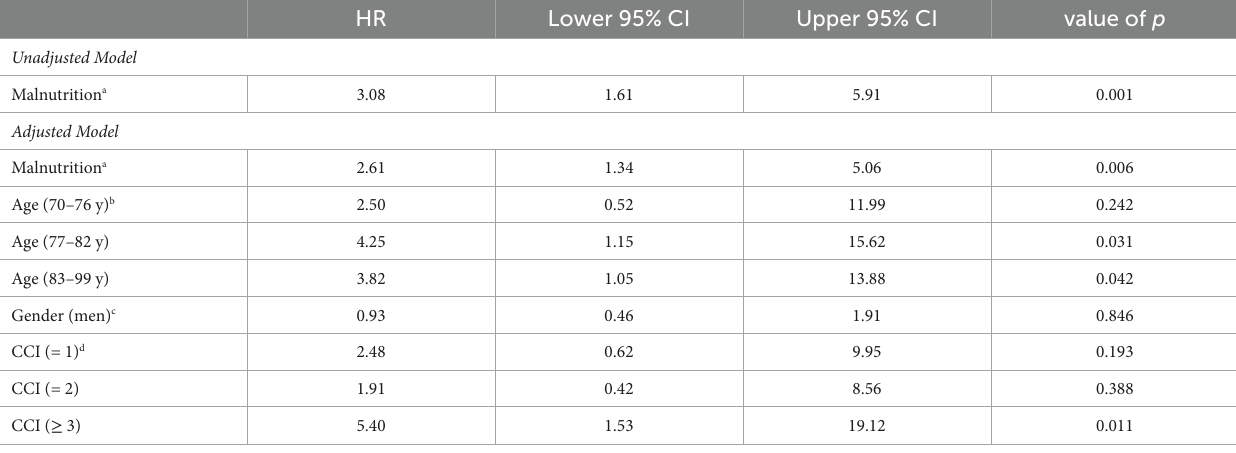
TABLE 3 Cox proportional hazards model of six-month mortality among patients with hip fracture. HR Lower 95%